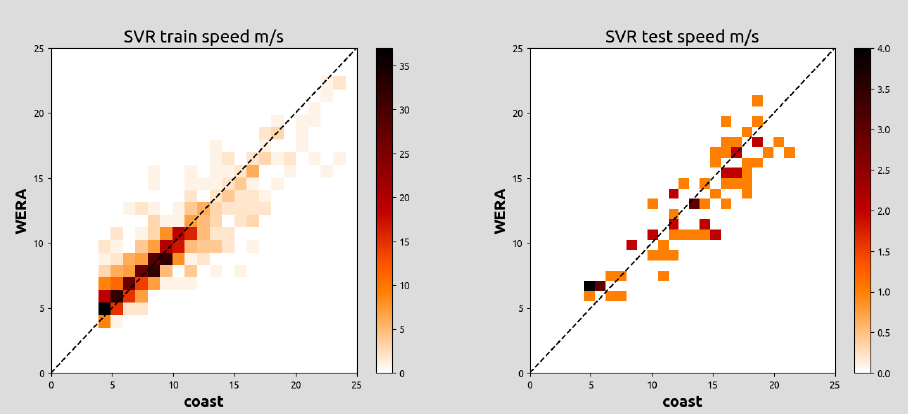
Figure 4. Comparison of south Celtic Sea SVR wind speeds with onshore anemometer. Left: training right: test. Colour-coding is number of cases in each bin.